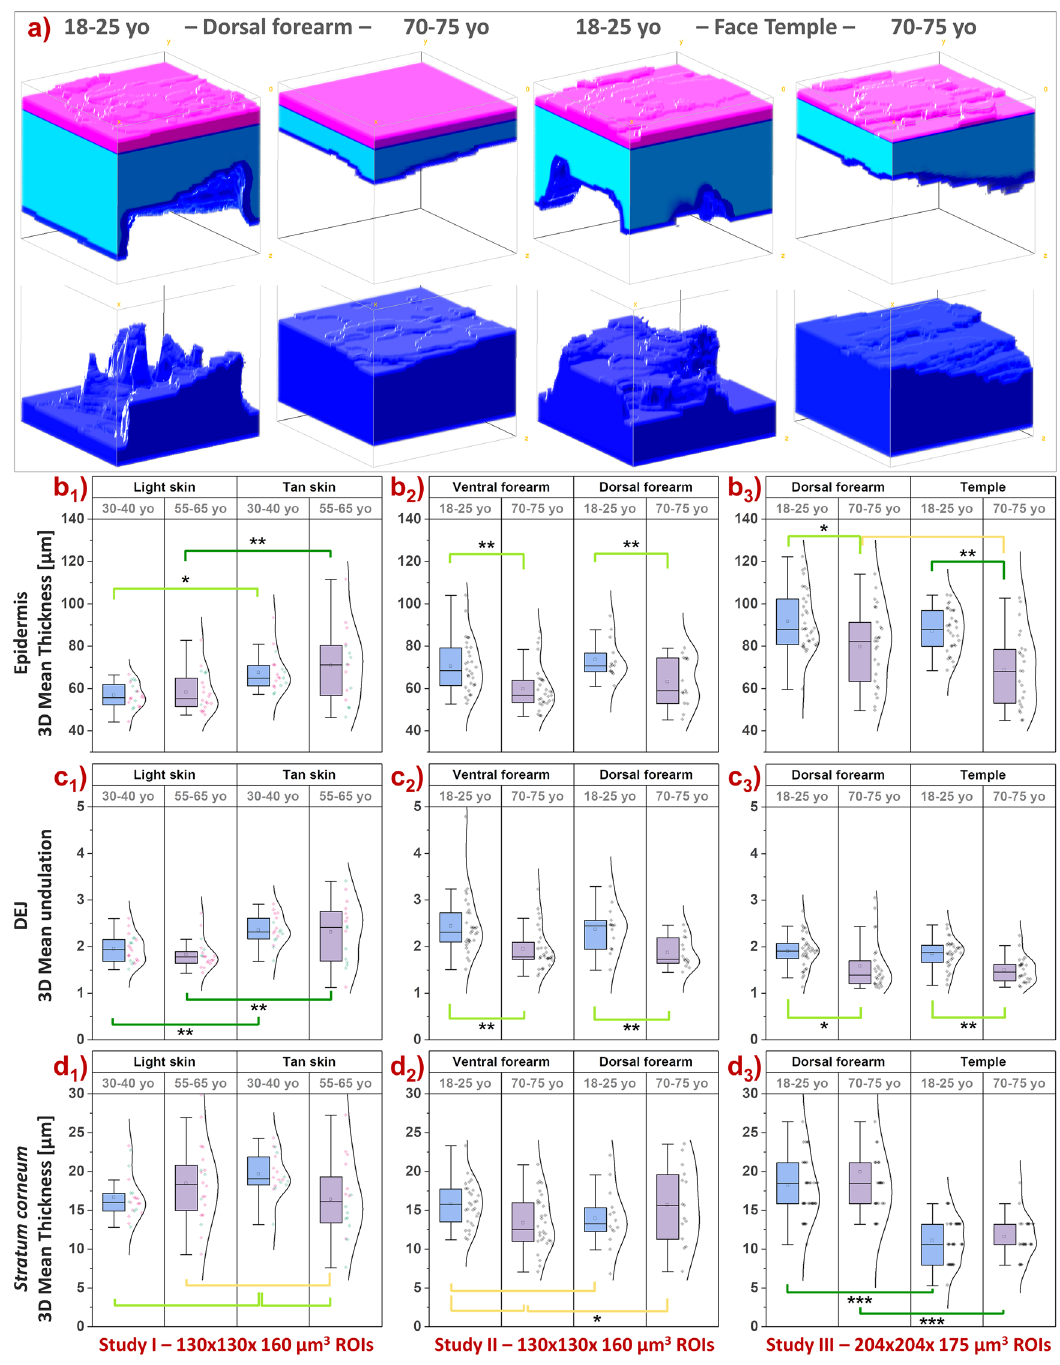
Figure 4. Multiphoton—Aging differences in 3D skin morphology of ventral and dorsal forearms and face temple area. Data from 3 clinical trials: Study I acquired with DermaInspect on ventral forearm (30–40 vs 55–65 year-old; “light” ITA vs “tan” ITA skin color groups); Study II acquired with DermaInspect on ventral and dorsal forearms (18–25 vs 70–75 year-old); Study III acquired with MPT flex on dorsal forearm and face temple area (18–25 vs 70–75 year-old). ( a ) 3D reconstructions of epidermal and dermal volumes of dorsal forearm and face temple area of a young and respectively old volunteers with epidermal thickness and DEJ undulation values close to the mean values of the study III groups. ( b1 – b3 ) Mean epidermal thickness; ( c1 – c3 ) Mean 3D DEJ undulation; ( d1 – d3 ) Mean stratum corneum thickness. The ventral forearm data in b2 and c2 are adapted from Decencière et al . Skin Res Technol 19, 115–124, 2013 (Fig. 6a,b 13 ). The raw data are expressed as box plots with fences, mean and median (—). All ROIs values and their distribution (dots ( ♦ ) and histogram) are shown on the right side of the boxplot. Overlapping values are highlighted in black ( ♦ ). In study I, the pink ♦ and green ♦ data points correspond to respectively women and men volunteers. The mean and median values with their errors are given in Table S2. All the statistical p -values and ES parameters are given in Table S3. Statistically significant p -values: *≤ 0.05; **≤ 0.01, ***≤ 0.001. The colored brackets indicate the ES—effect size (dark green—very strong [1.3–Inf], light green—strong [0.8–1.3] and yellow—moderate [0.5–0.8]). Only p -values associated with moderate to very strong ES are